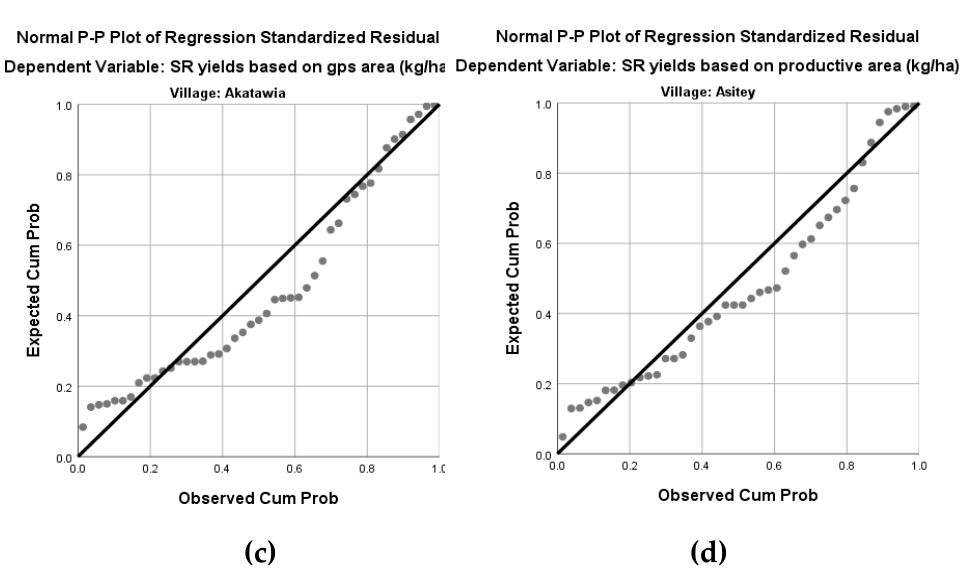
Figure 3. Normal probability-probability plot of regression residuals showing deviations CC and SR yields at both Akatawia and Asitey: ( a ) normal p-p plot of regression residuals for Akatawia using crop cut yields as dependent variables; ( b ) for Asitey using crop cut yields as dependent variables; ( c ) for Akatawia using farmers’ self-reported yields as dependent variables; ( d ) for Asitey using farmers’ self-reported yields as dependent variable.